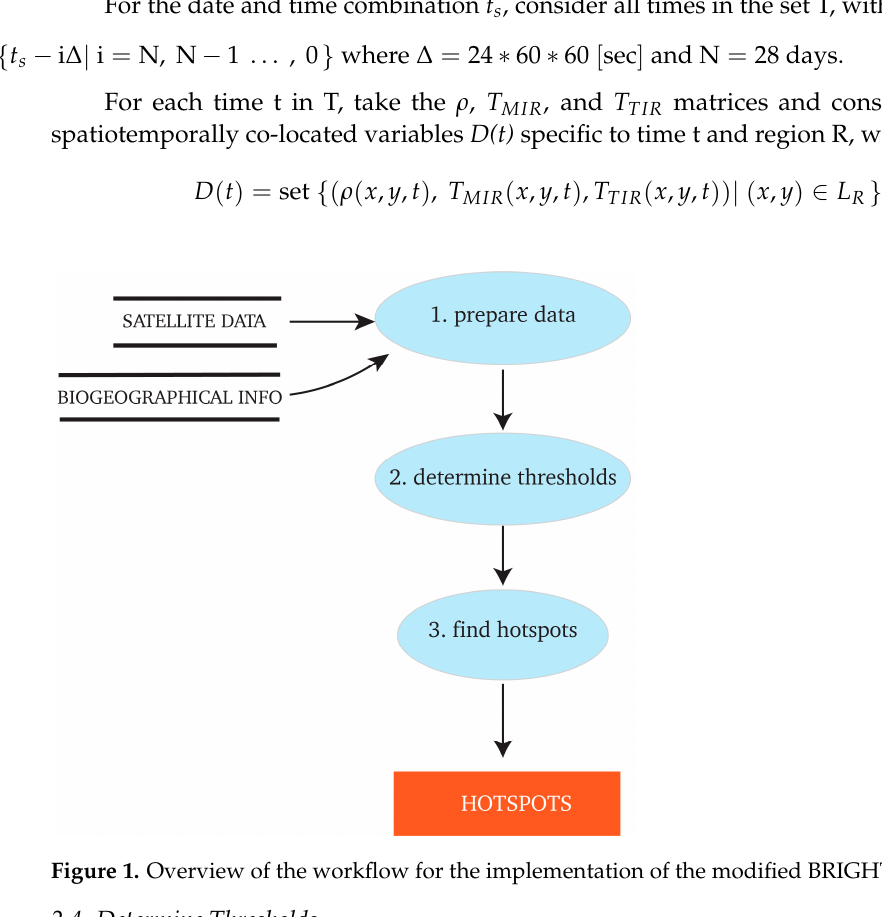
Figure 3. Schematic showing the determination of thresholds for the implementation of the modi- fied BRIGHT algorithm. 2.5. Hotspots